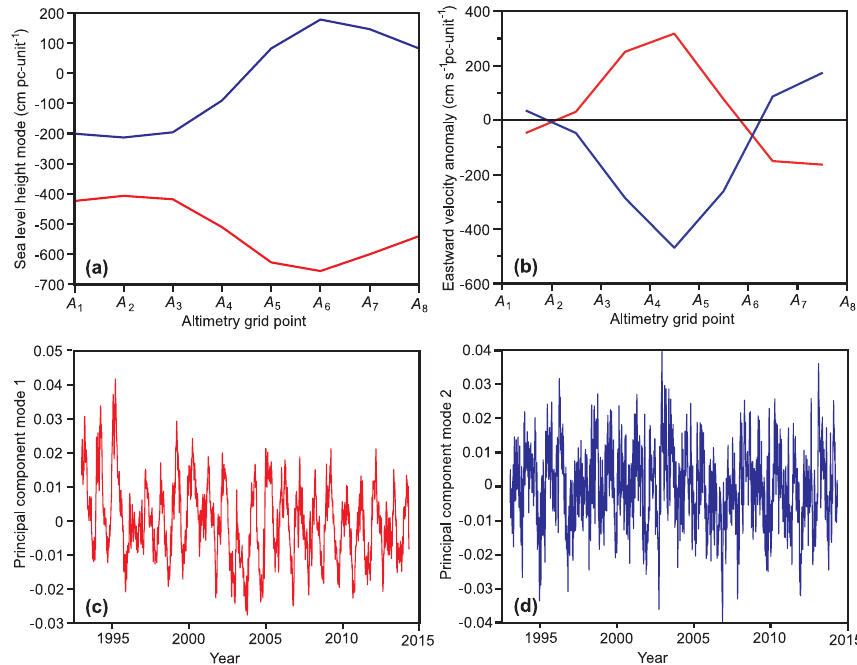
Figure 3. The first two EOF modes of the altimetry data and their principal components. (a) SLA mode 1 (red) and 2 (blue). (b) The eastward surface velocity anomaly associated with SLA mode 1 (red) and 2 (blue) using Eq. (1) with U 0